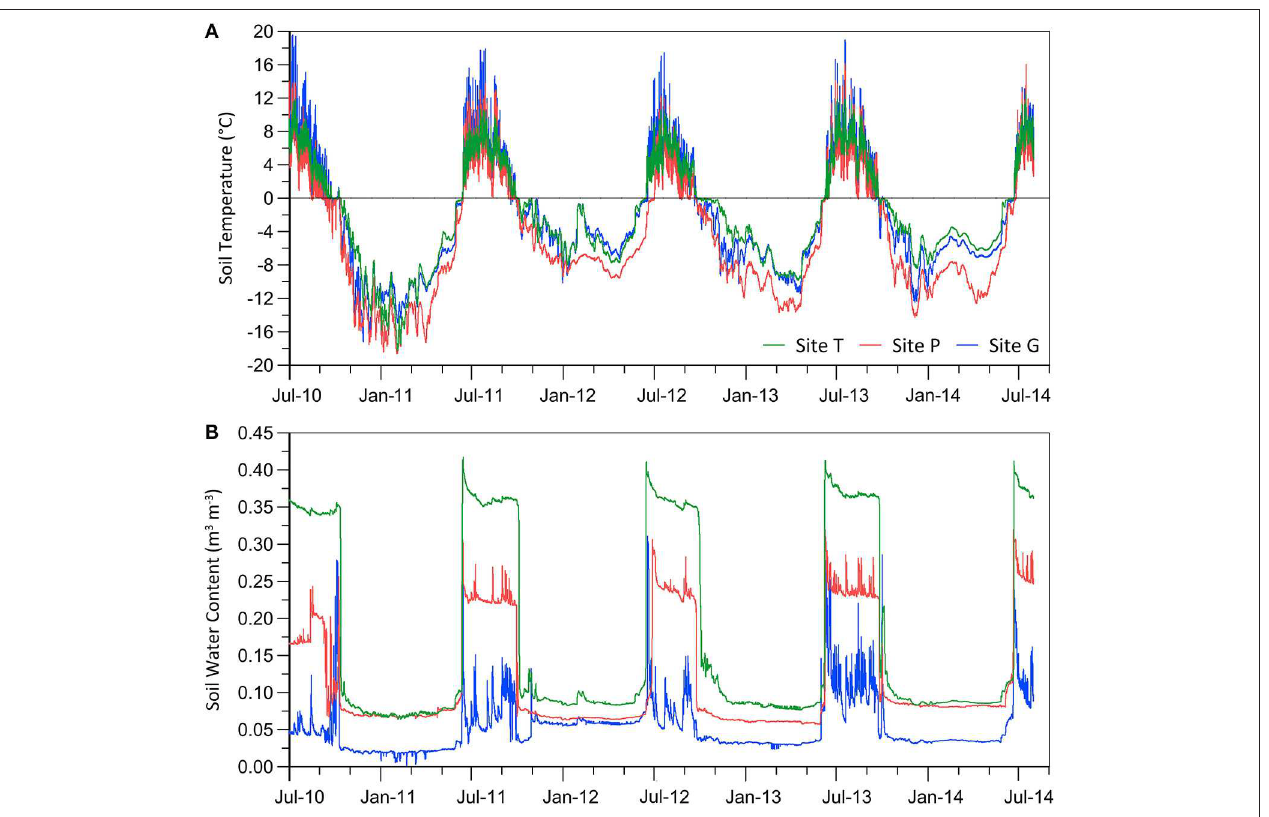
FIGURE 2 | Soil temperature (A) and soil water content (B) in the three studied sites in the period of